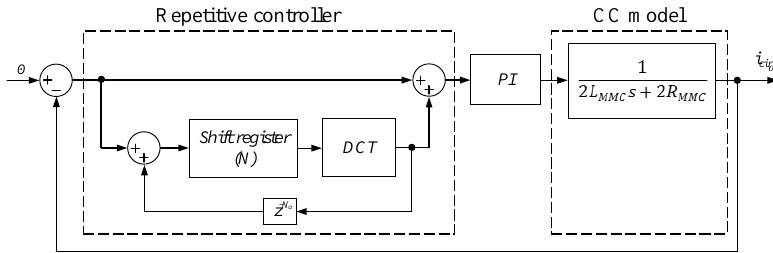
Figure 16. Circulating current control scheme based on repetitive controller.